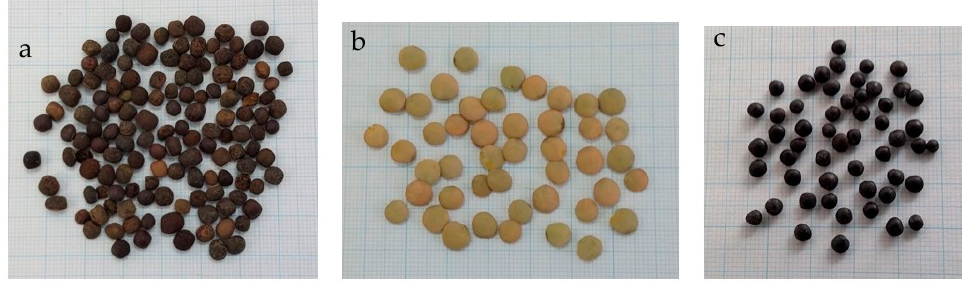
Figure 1. Seeds of tested landraces. lenticchia nera from Soleto ( a ); lentil from Altamura ( b ); cv . Beluga ( c ).